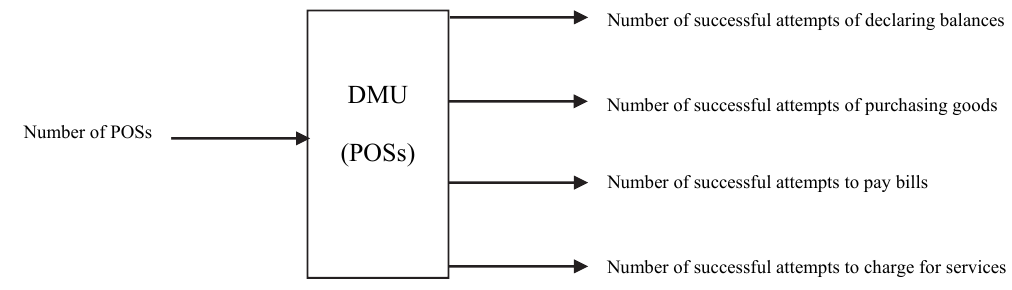
Number of successful attempts of declaring balances